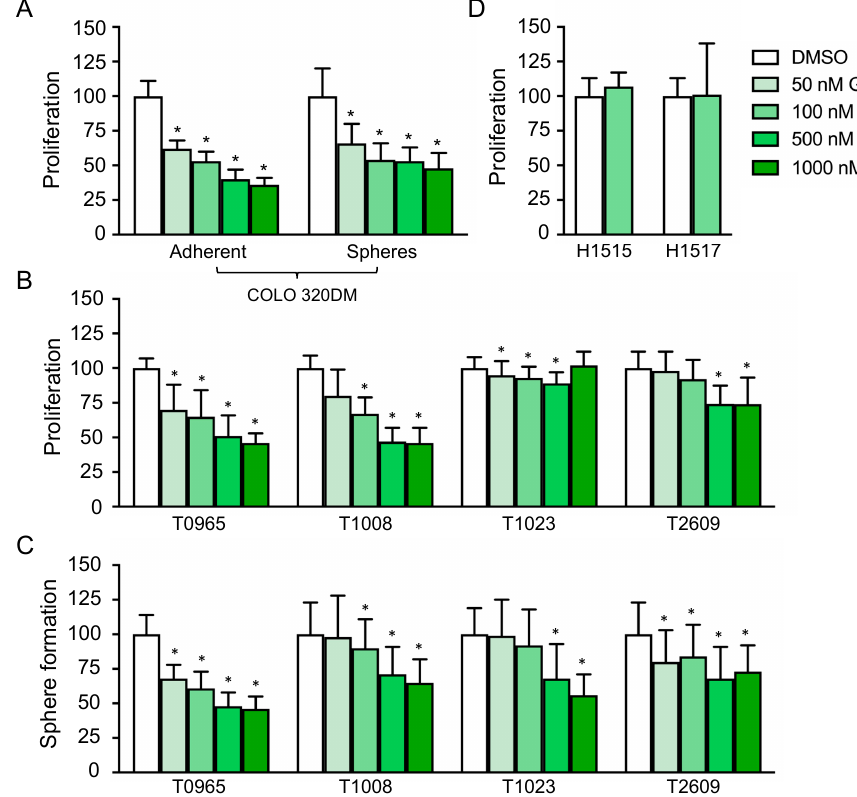
Figure 1. G007-LK reduces proliferation and sphere formation in primary glioma stem cell (GSC) cultures. ( A ) Proliferation of COLO 320DM cells treated with G007-LK or DMSO (0.01%) using both adherent (left panel) and sphere-forming (right panel) culture conditions; ( B ) Proliferation of GSCs treated with G007-LK or DMSO (0.01%); ( C ) Sphere formation of GSCs treated with G007-LK or DMSO (0.01%); ( D ) Proliferation of ahNSCs treated with G007-LK (100 nM) or DMSO (0.002%). Proliferation was measured by XTT assays and sphere formation as the total number of spheres formed in sphere formation assays, both after 14 days of treatment. Values are expressed as percentages relative to the DMSO control. The results are presented as the mean ± SD. * p < 0.05.